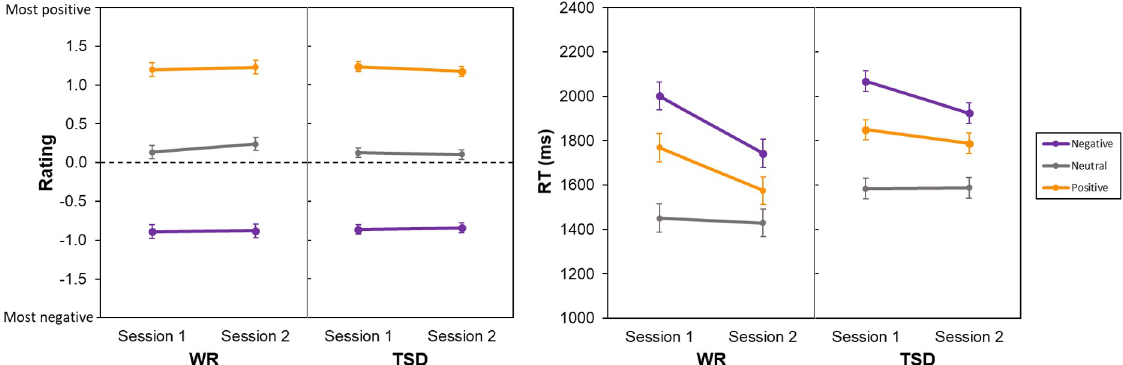
Fig 5. Valence ratings (mean ± SE) on the affective categorization task for each stimulus type, in the WR and TSD conditions (left). Response times (mean ± SE) on the affective categorization task for each stimulus type, in the WR and TSD conditions (right).